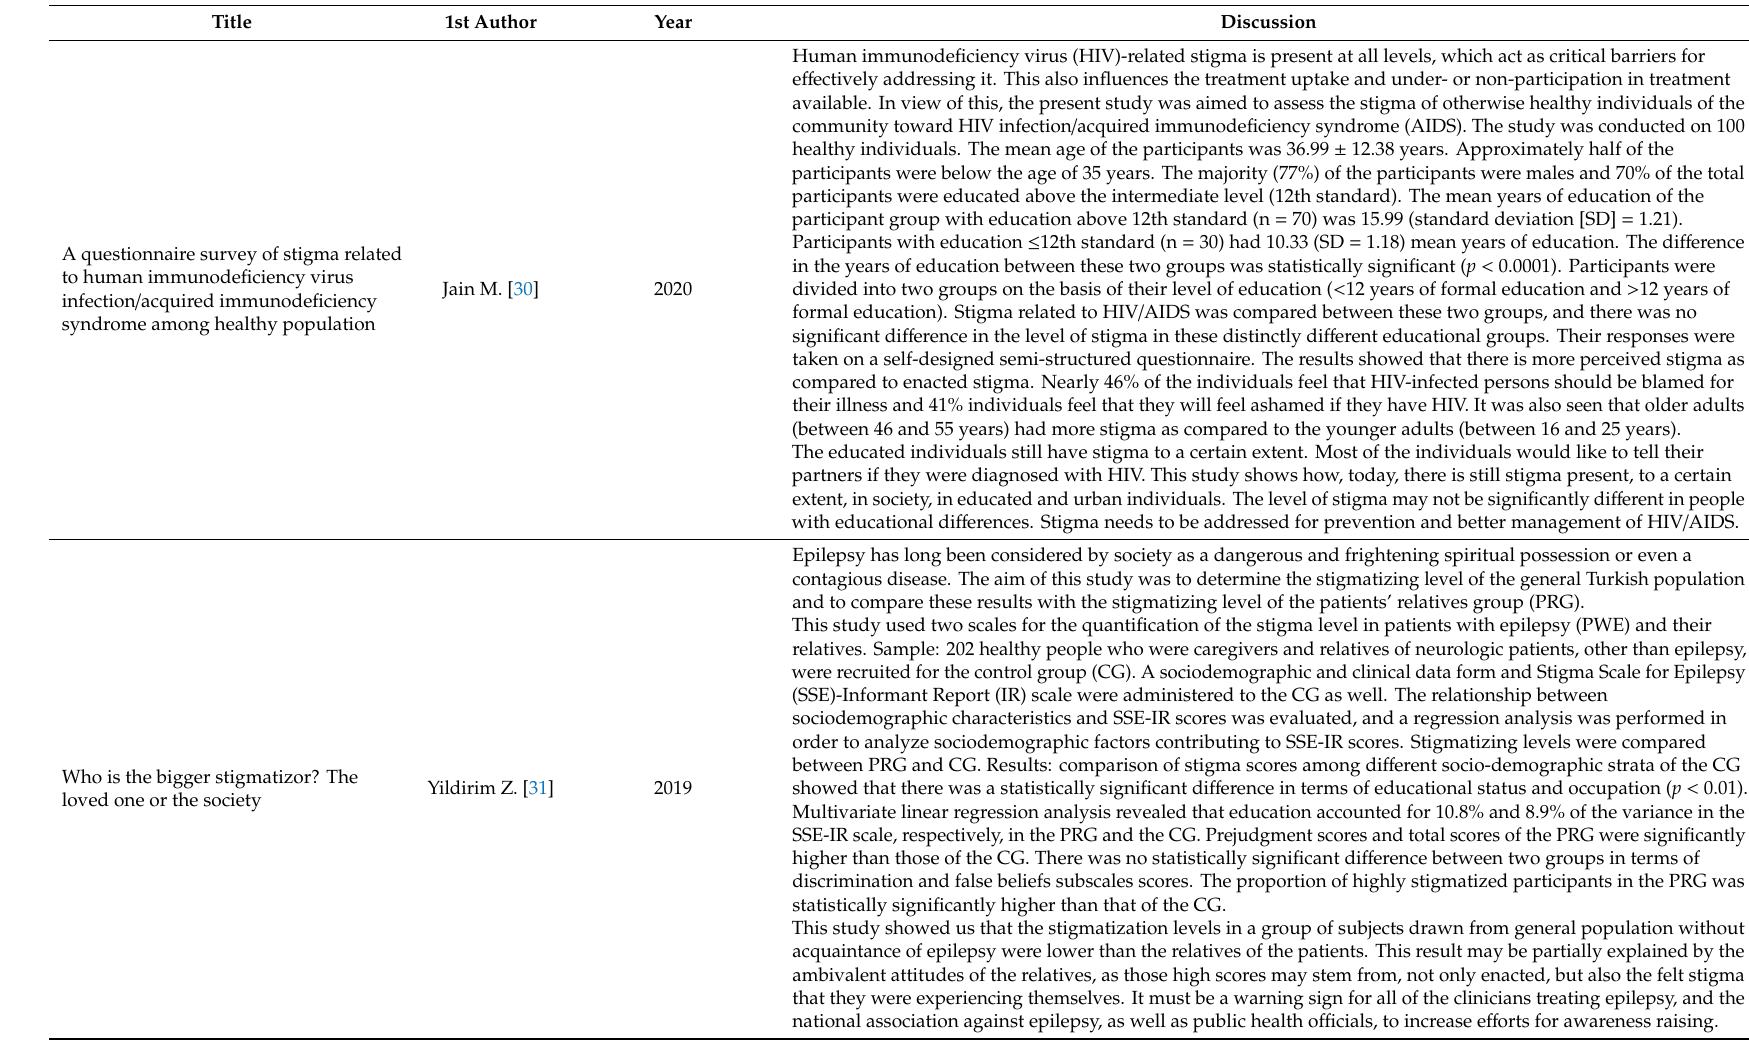
Table 3. Analysis of the